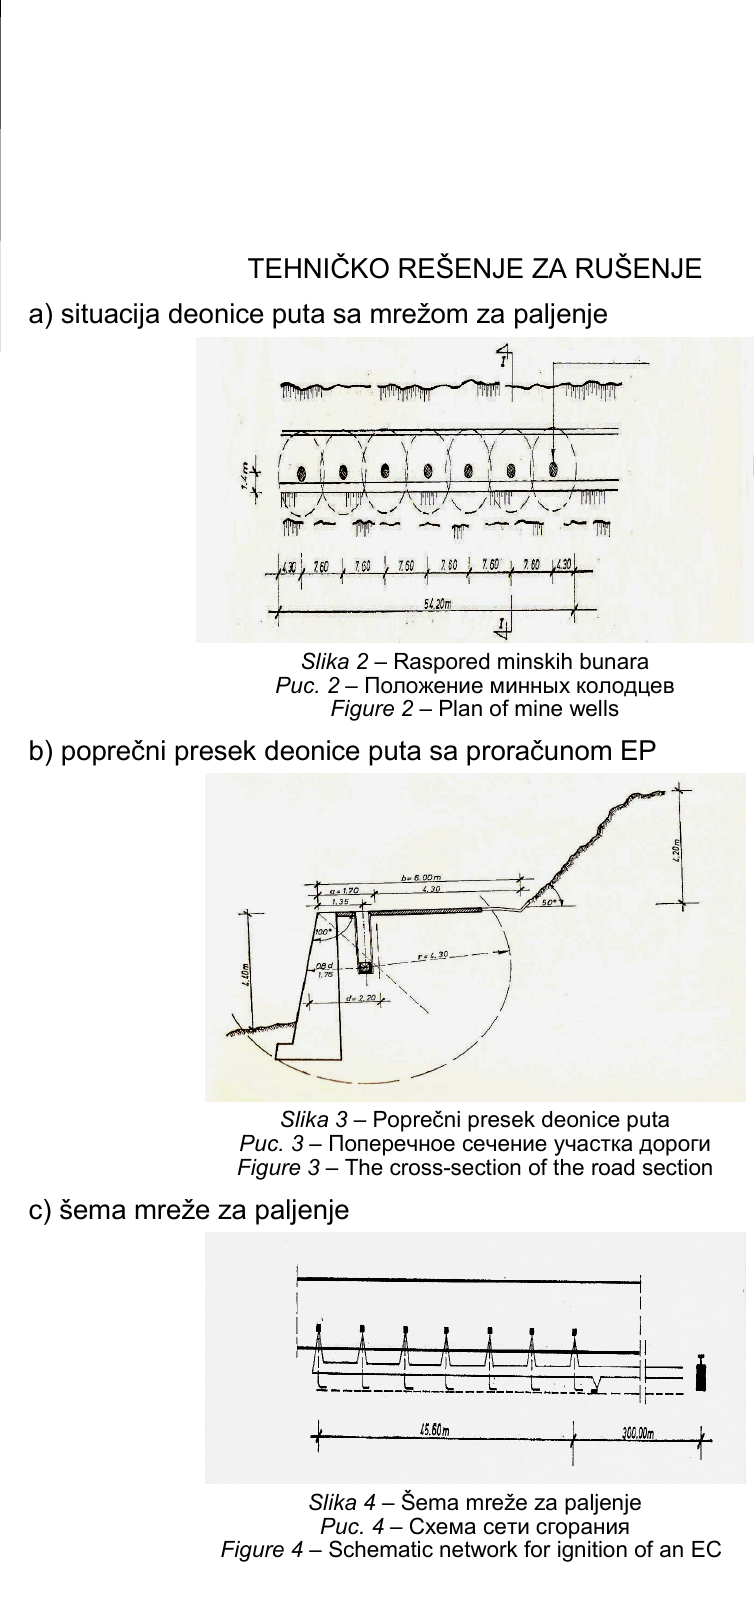
Figure 4 – Schematic network for ignition of an